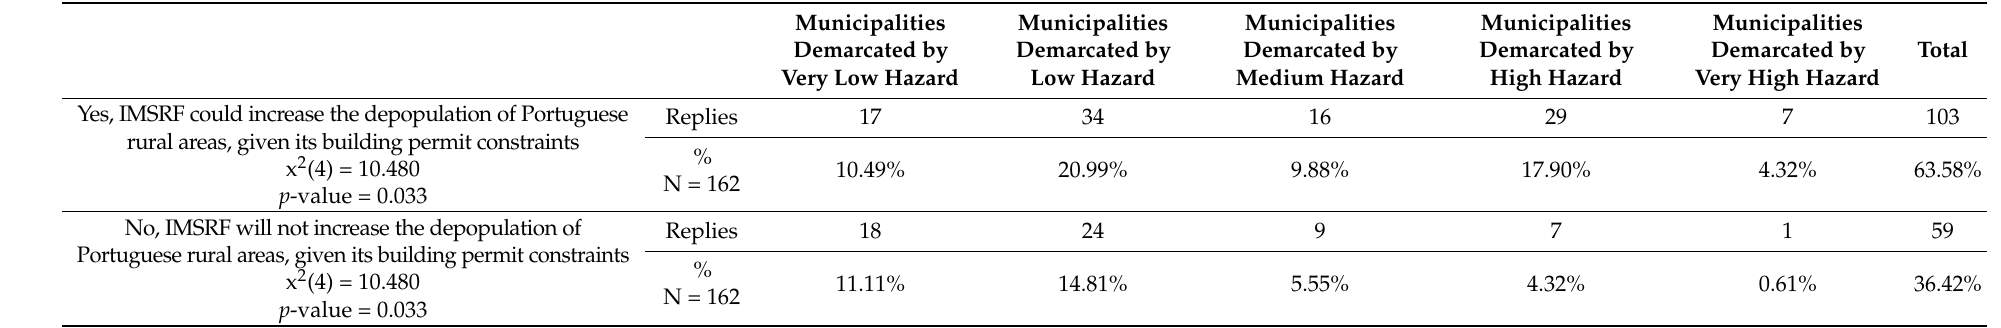
Table 3. Relationships with statistical significance established between the recognition of the depopulation potential of the IMSRF, the lack of recognition of the depopulation potential of the IMSRF , and the influence of hazard in municipalities .